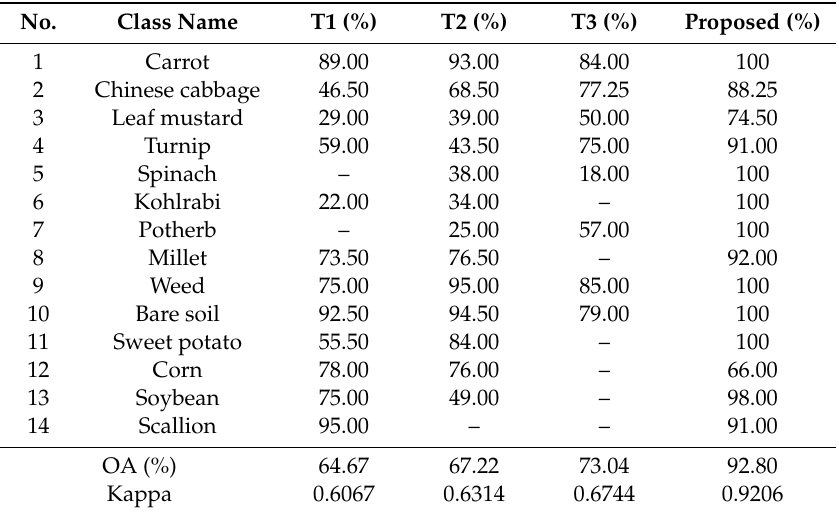
Table 5. Class-level accuracy for mono- and multi-temporal